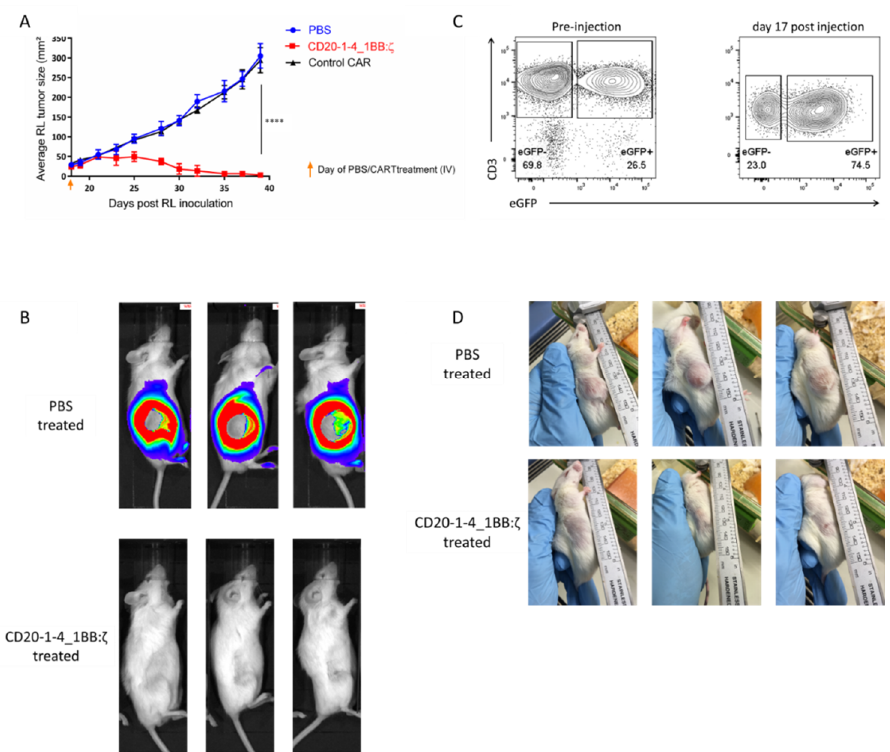
Figure 6. CD20 nanoCAR eradicates CD20 + tumor in a murine xenograft model: ( A ) Tumor size measured by caliper. Data points shown are the means, error bars represent the SEM, and only significant results are indicated. **** p < 0.0001 by two-way ANOVA with Bonferroni’s multiple comparison test; ( B ) Bioluminescence images showing tumor burden in NSG mice at day 39 post RL inoculation; ( C ) Images showing tumor burden in NSG lice at day 39 post RL inoculation; ( D ) Expression of eGFP in T cells transduced with the CD20-1-4_1BB: ζ naoCAR pre-intravenous injection and in T cells circulating in blood on day 35 post RL injection (day 17 post CAR T cell injection). Plot shown is representative for five mice.